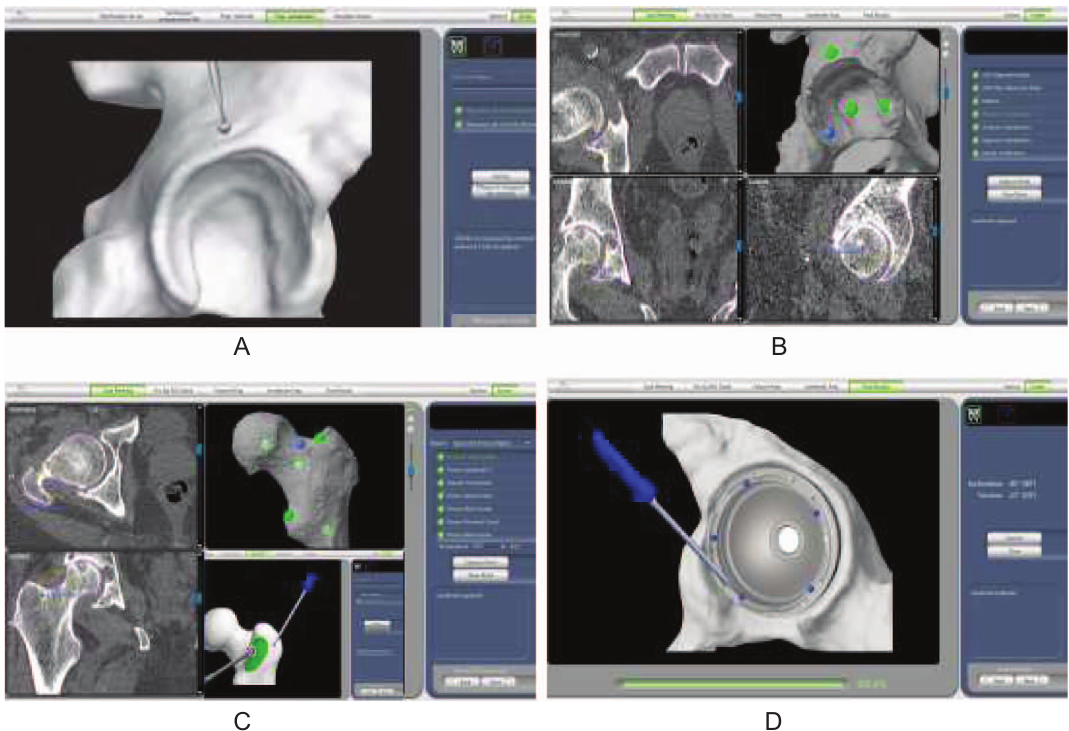
Figure 3. Intraoperative procedure: positioning of the acetabular landmarks (A), pre-operative mapping process of the acetabulum (B), the proximal femur (C) during an enhanced THA procedure with the positioning of the femoral marker before its mapping, control of the fi nal acetabular cup positioning using the pointer